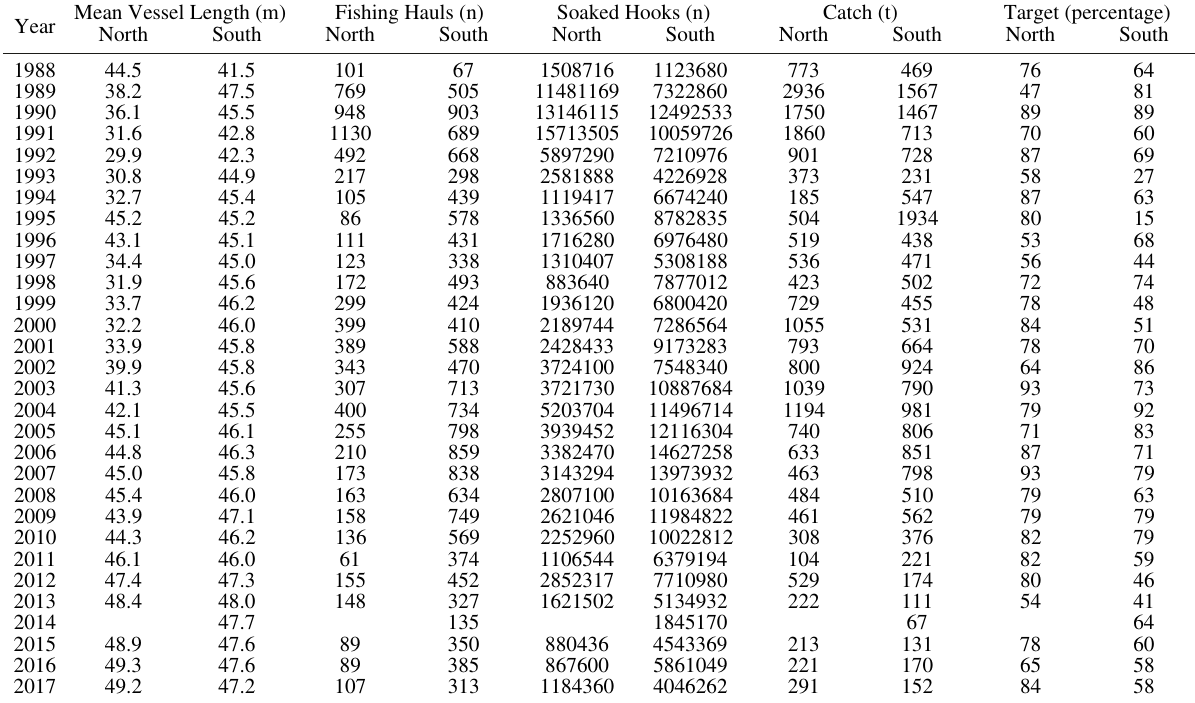
Table 1. – Summary of operational characteristics of the longline industrial fishery in southern Chile. North and South refer to the fishing areas, catch indicates the total reported catch of pink cusk-eel. Target refers to the percentage of the total catch per year intending to target pink cusk-eel (Scenario 3, variable fishing